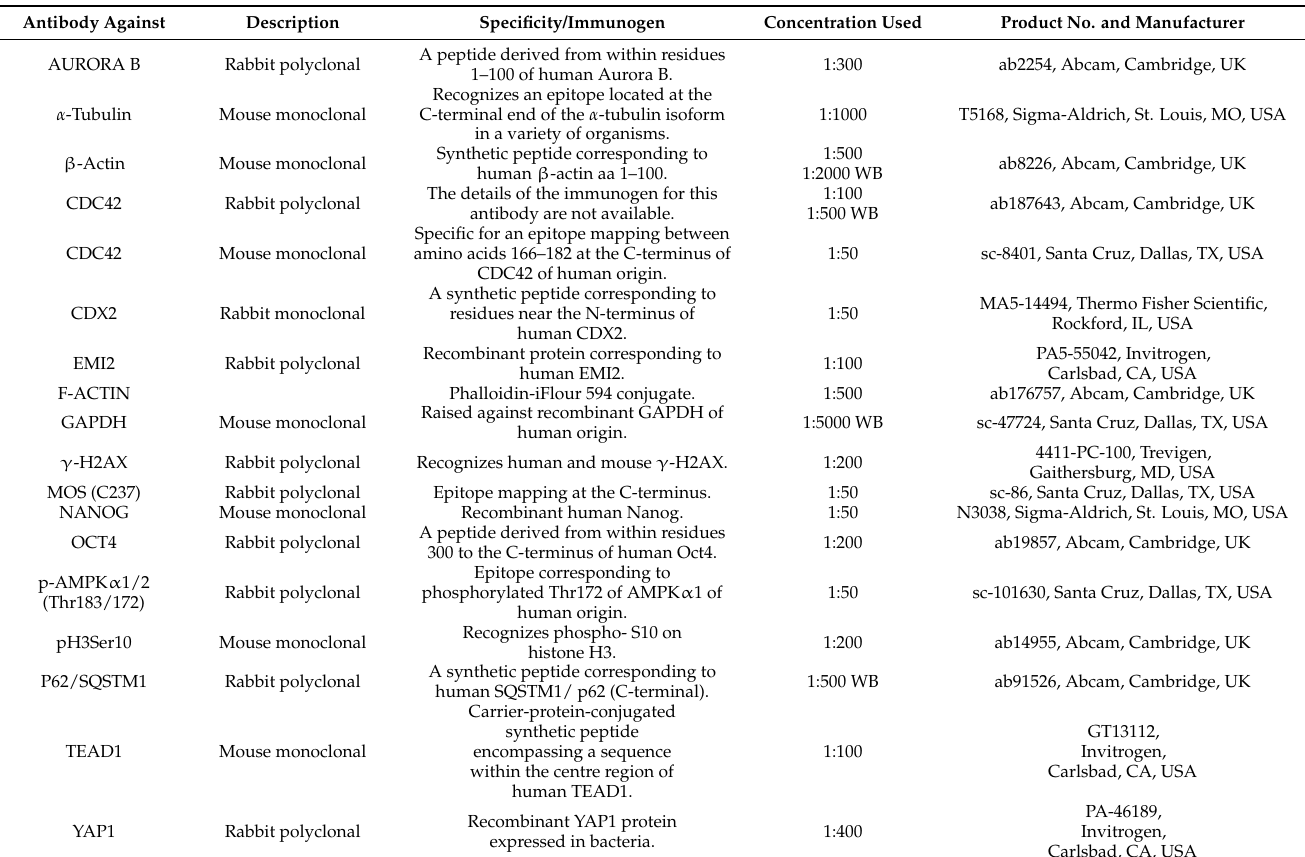
Table 2. Antibodies used, their specificity, and